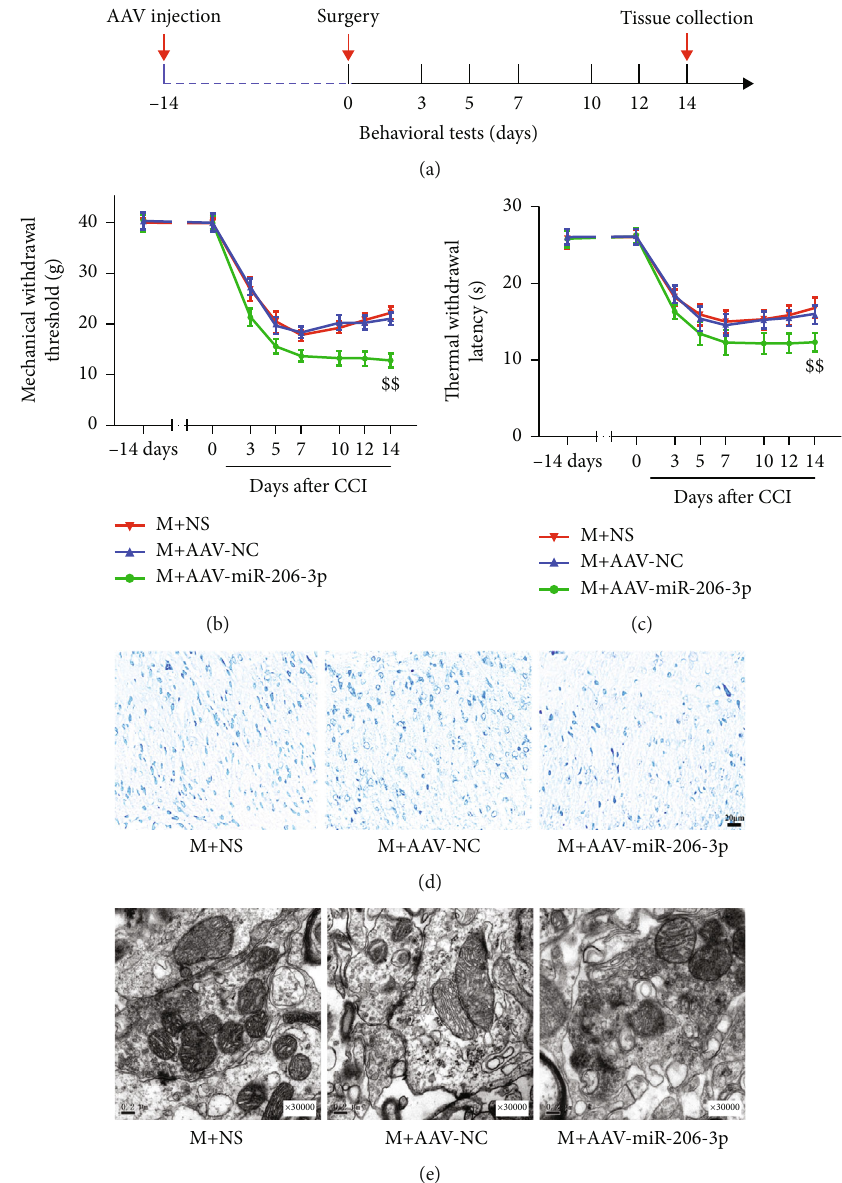
Figure 3: A miR-206-3p inhibitor aggravates hyperalgesia in CCI rats and damage to spinal dorsal horn neurons. (a) Experimental design and timeline. (b, c) MWT and TWL in each group ( n = 14 ). (d) Nissl staining images (scale bars: 20 μ m, 50x). (e) The ultrastructural changes of synapses in each group (0.2 μ m, 30000x). $$ p < 0 : 01 versus the M+NS